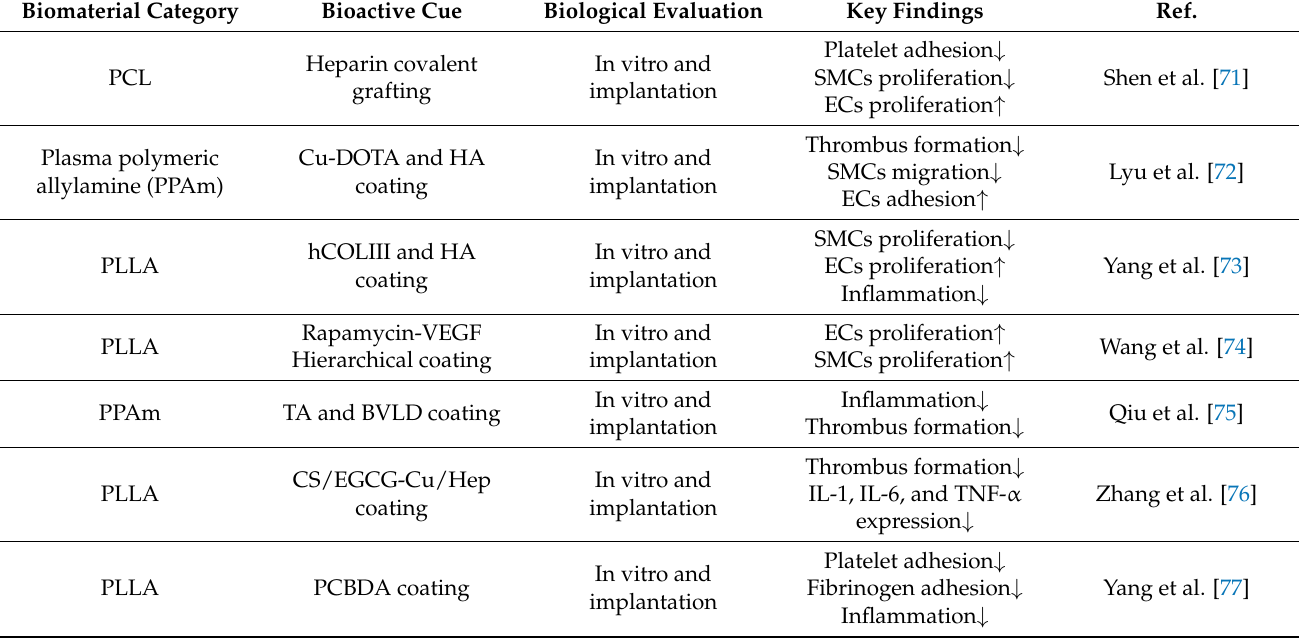
Table 4. Summary of biological modification of biodegradable